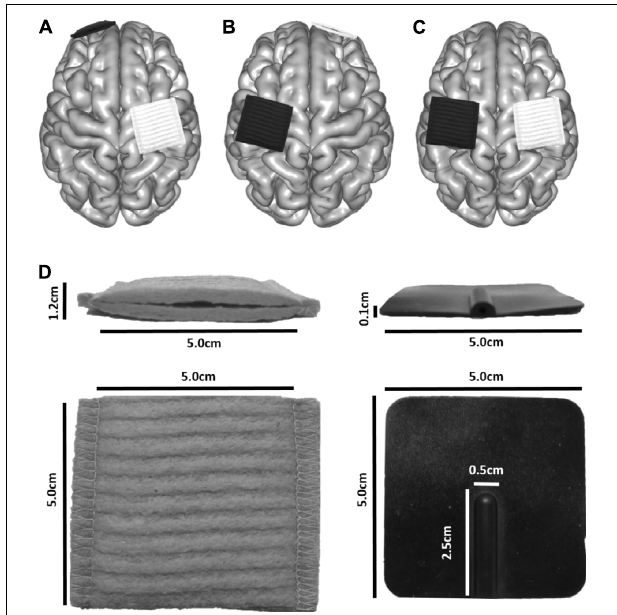
FIGURE 2 | Electrode placement for three montages typically used in motor learning paradigms to enhance skill acquisition of the left hand. The white electrode depicts the anode, and the black the cathode. (A) M1 L -SO R , (B) SO L -M1 R , (C) M1 R -M1 L . (D) Electrode dimensions.